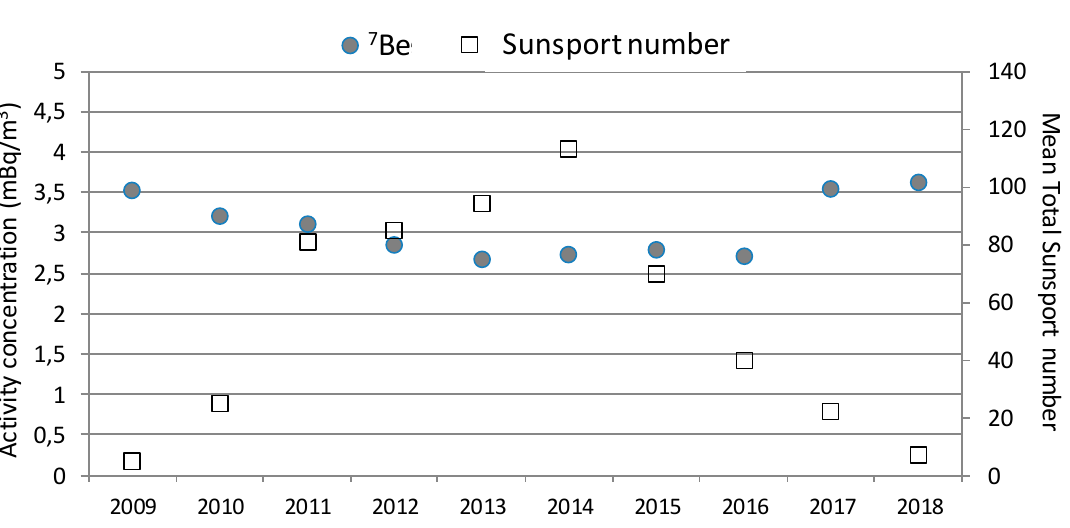
Figure 6. Yearly variations in the 7 Be activity concentration in Bilbao and sunspot number from 2009 to 2018 (Note: Sampling station failed during summer 2016).